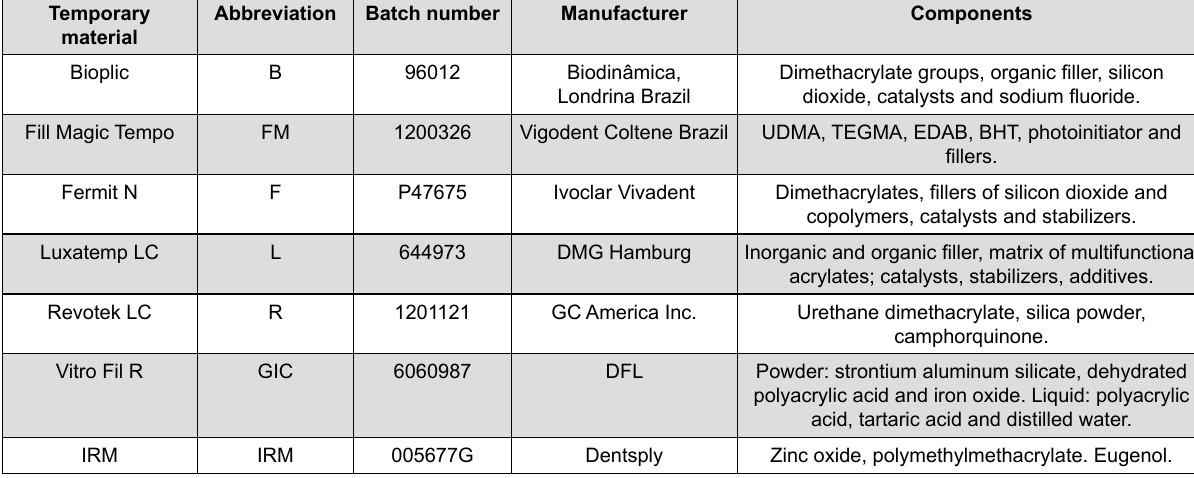
Figure 1- Composition of the materials used in this